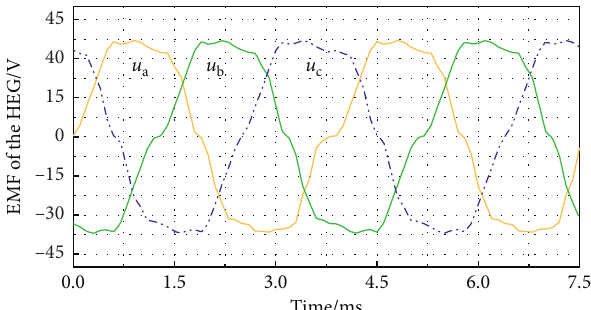
Figure 18: Three-phase induced EMF waveforms of the PMCHEG.